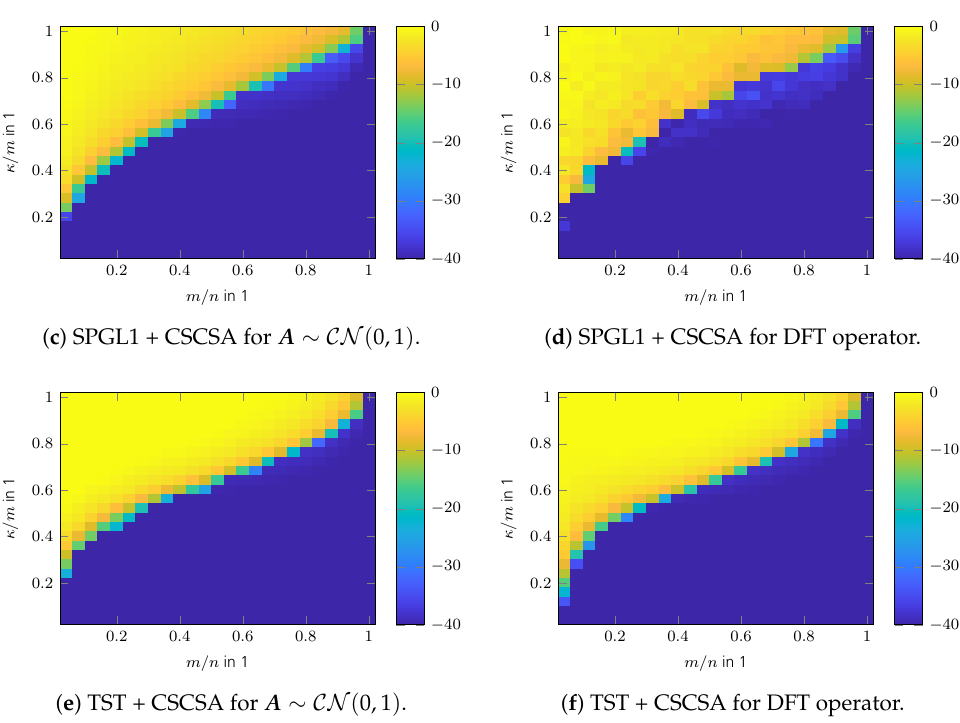
Figure 7. Phase transition of refined CS algorithms in SRE in dB.